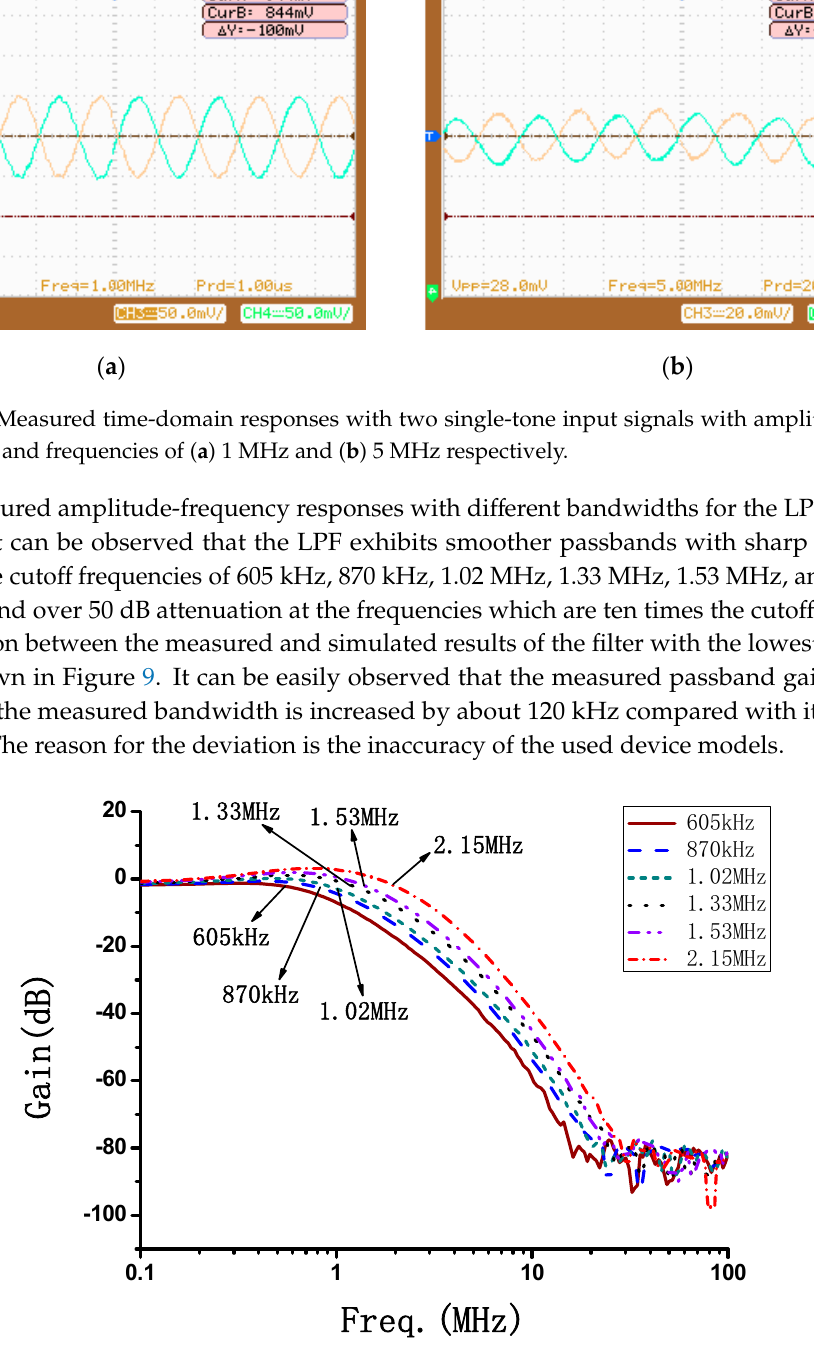
Figure 8. Measured amplitude-frequency responses with different bandwidths.